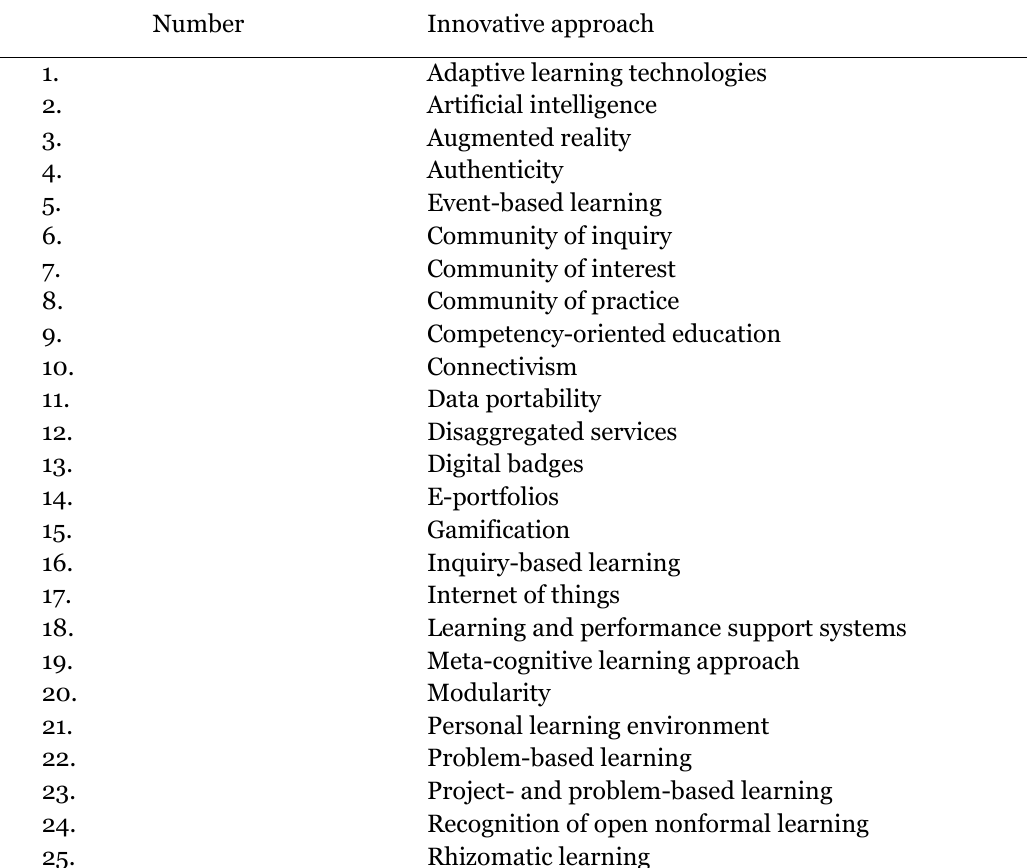
Innovative Approaches to Teaching in Higher Education